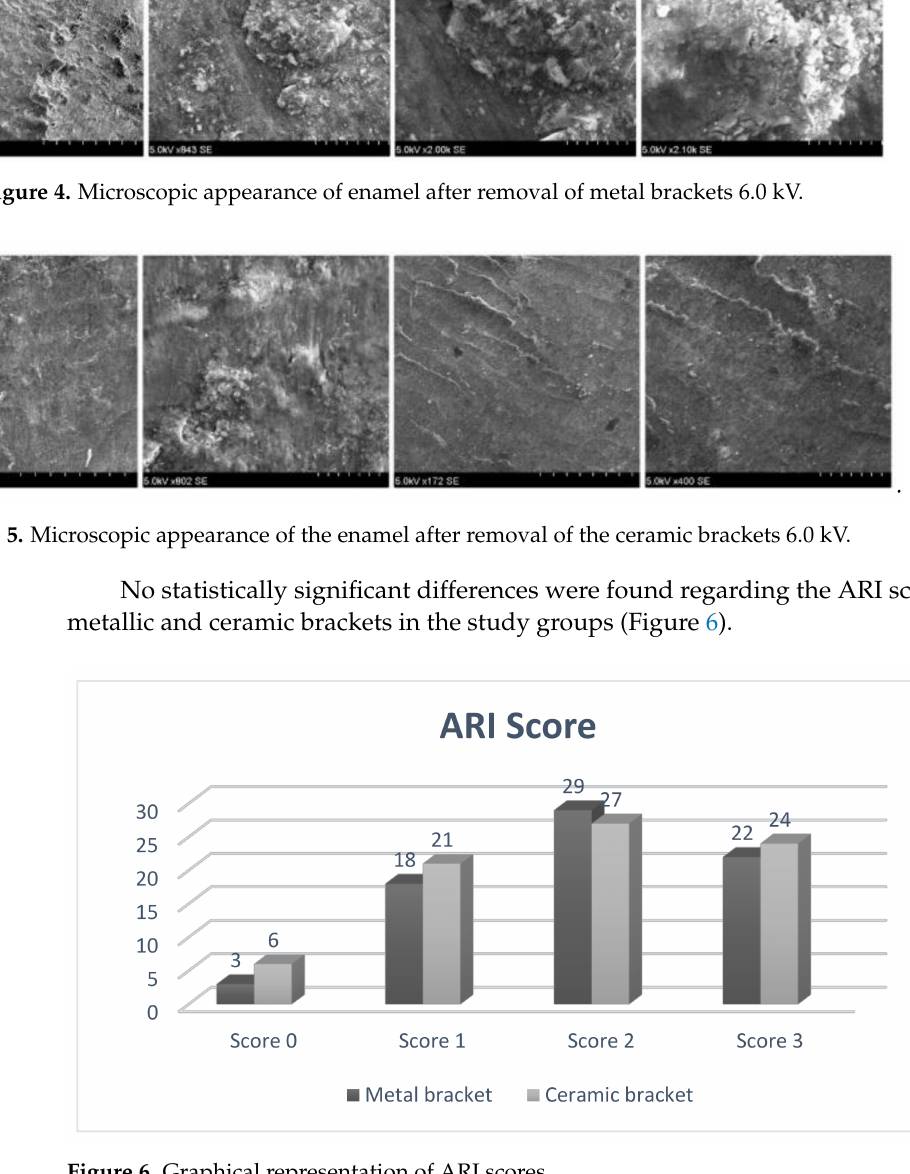
Figure 6. Graphical representation of ARI